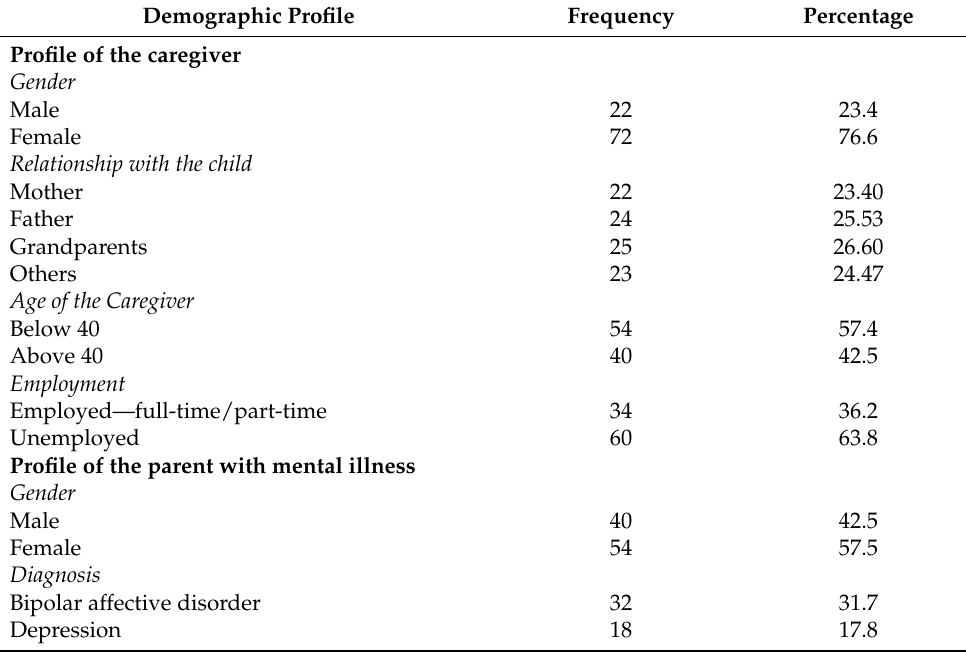
Table 1. Demographic profile of the parent with mental illness and their children.